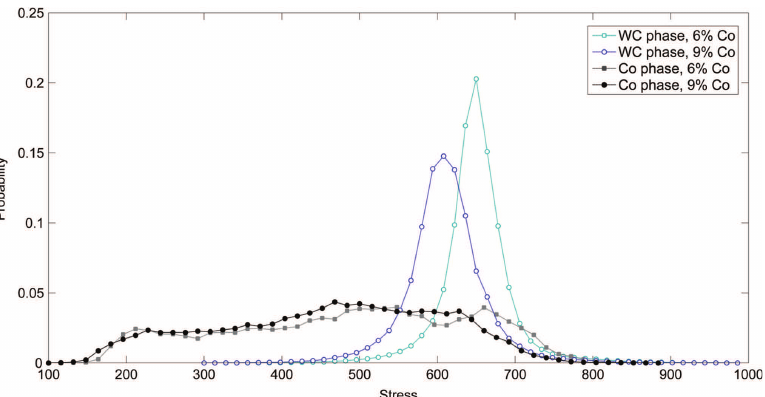
Figure 13: Distributions of the stresses σ 11 in the individual material phases with respect to the cobalt content, 2D model including continuous grain boundaries.